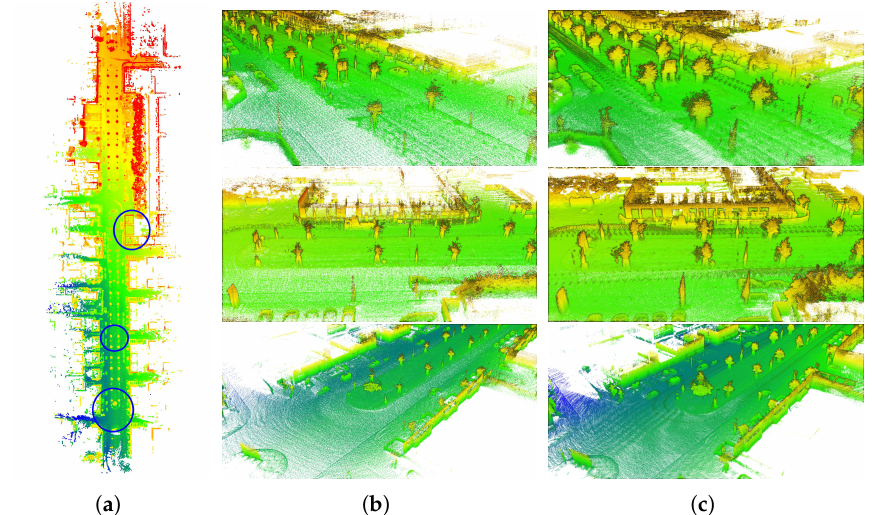
Figure 16. InTEn-LOAM’s map result on urban scenario (KITTI seq.06): ( a ) overview, ( b ) map in detail of circled areas, ( c ) reference map comparison.